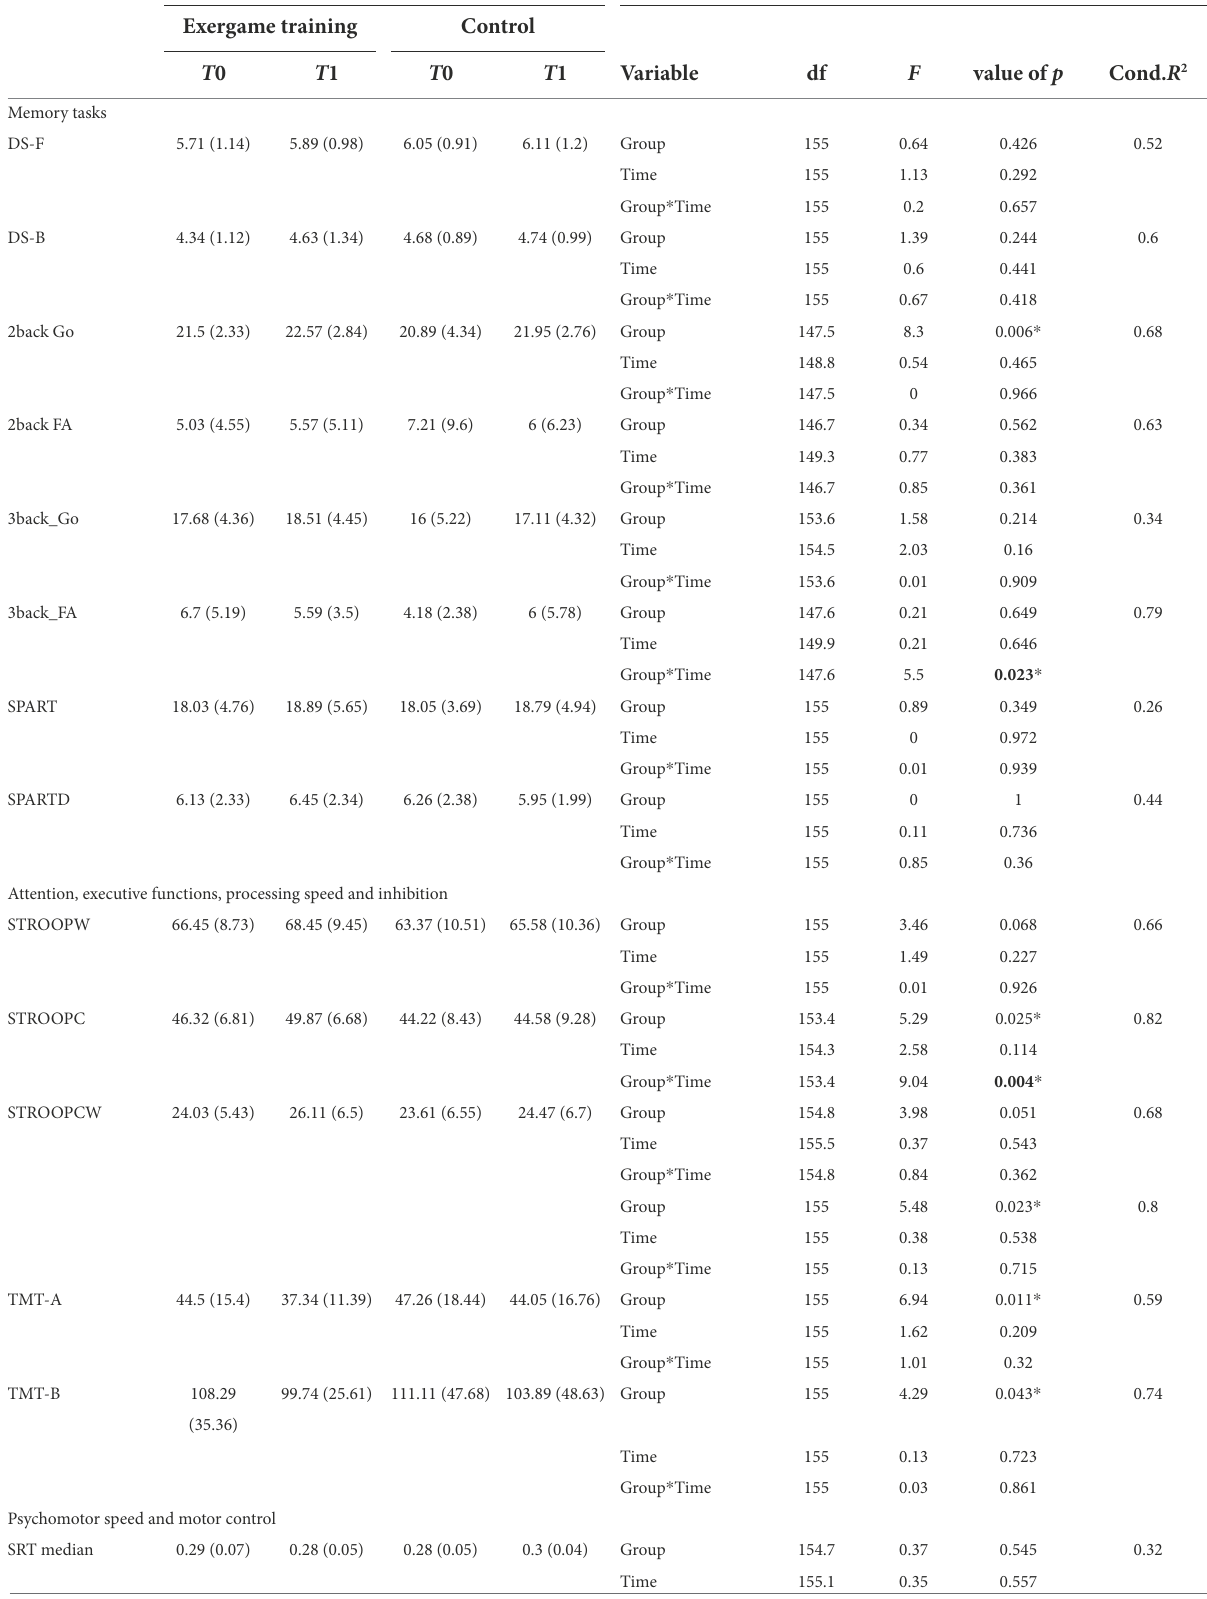
TABLE 3 Descriptive and inferential analysis of all measures tested. Measures